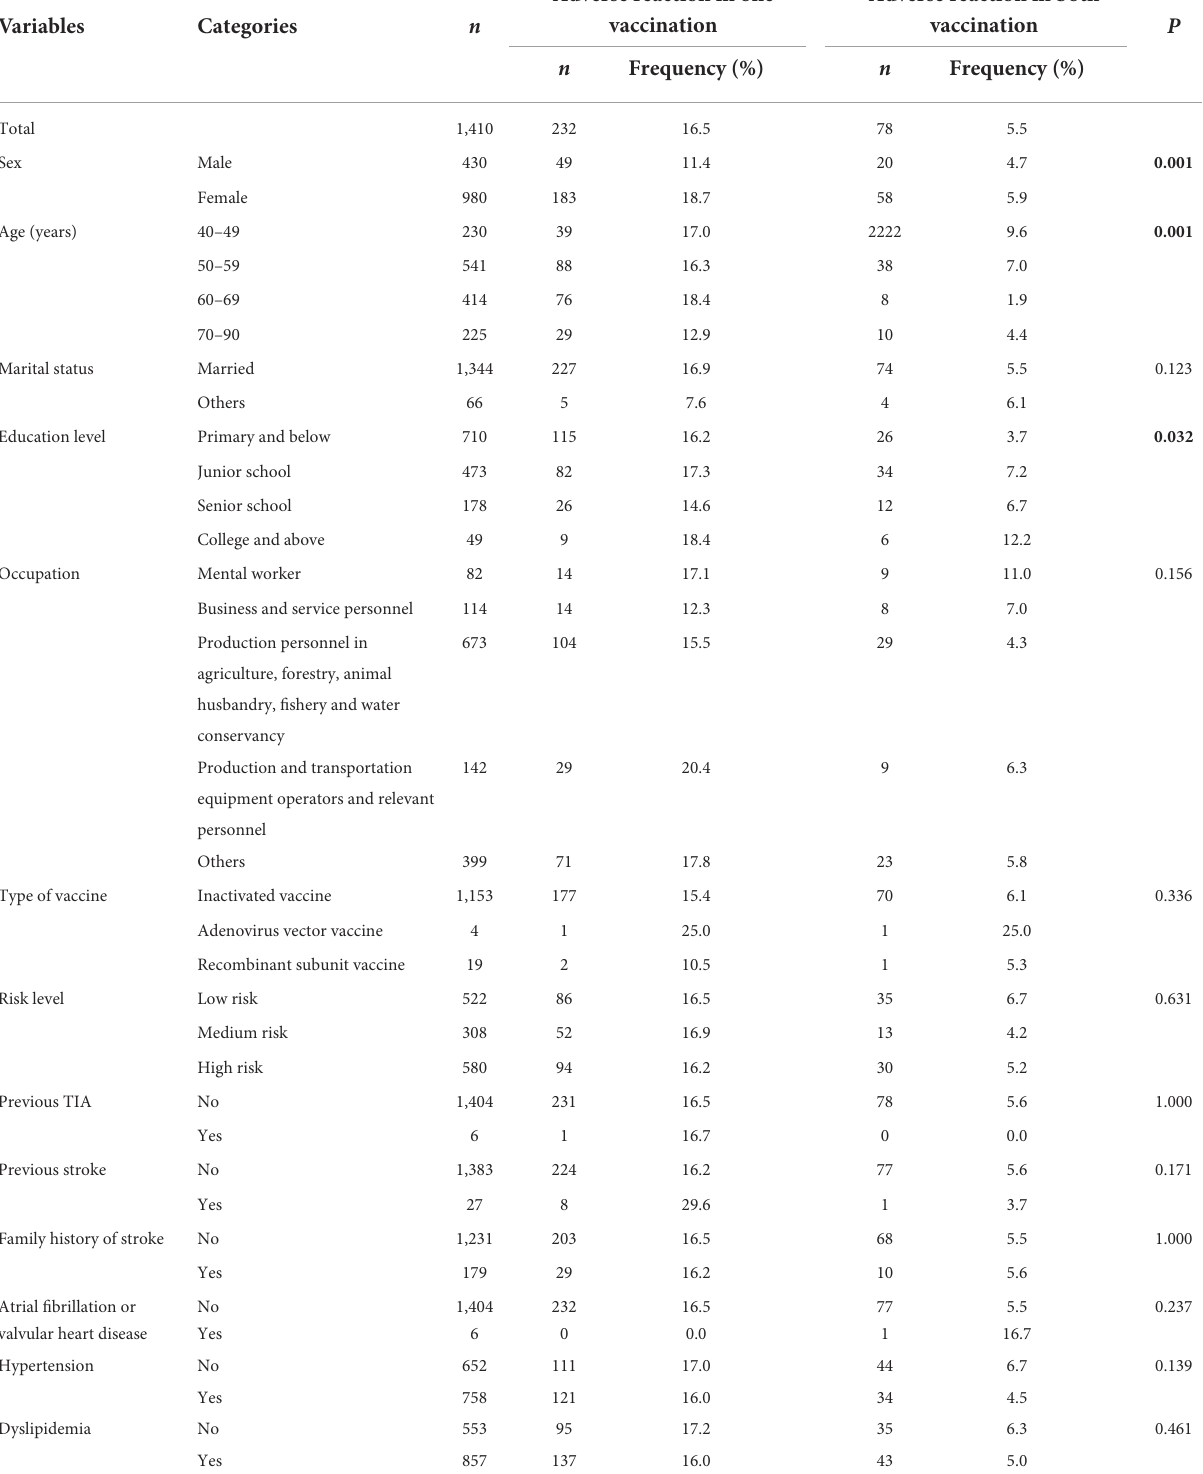
TABLE 4 Univariate analysis of factors associated with adverse reactions in completed two doses vaccinated group ( n = 1,410). Variables Categories n